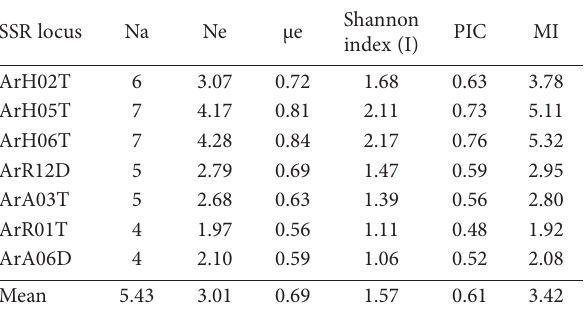
Table 3. Numbers of alleles (Na) and effective alleles (Ne), het- erozygosity (μe), Shannon indices, polymorphism information con- tent (PIC), and marker indices (MI) of SSR markers used for deter- mining genetic diversity of 75 Ascochyta rabiei isolates .